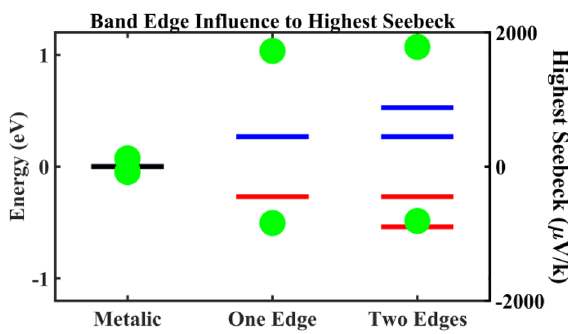
Figure 4. How the position and number of band edges are influencing the highest achievable Seebeck coefficient in a carbon nanotube network system. The first column specifies when the carbon nanotube network is metallic as in the measured sample, the Seebeck coefficient can only be as high as ~ 10 2 μV/K at 300 K for both p-type (positive value) and n-type (negative). The second column shows that the values of Seebeck can achieve ~ 10 3 μV/K when the band gap is 0.535 eV and only the first band edge, for either electrons or holes as marked by the van Hove singularity peaks in Fig. 1a, is participating in the transport. The third column shows the highest achievable Seebeck coefficient when the second band edge, for electrons or holes as also marked by the van Hove singularity peaks in Fig. 1a, is participating in the transport. It can be seen that the position has much more significantly influence on the Seebeck coefficient than the number of higher-energy band edges that contribute to the